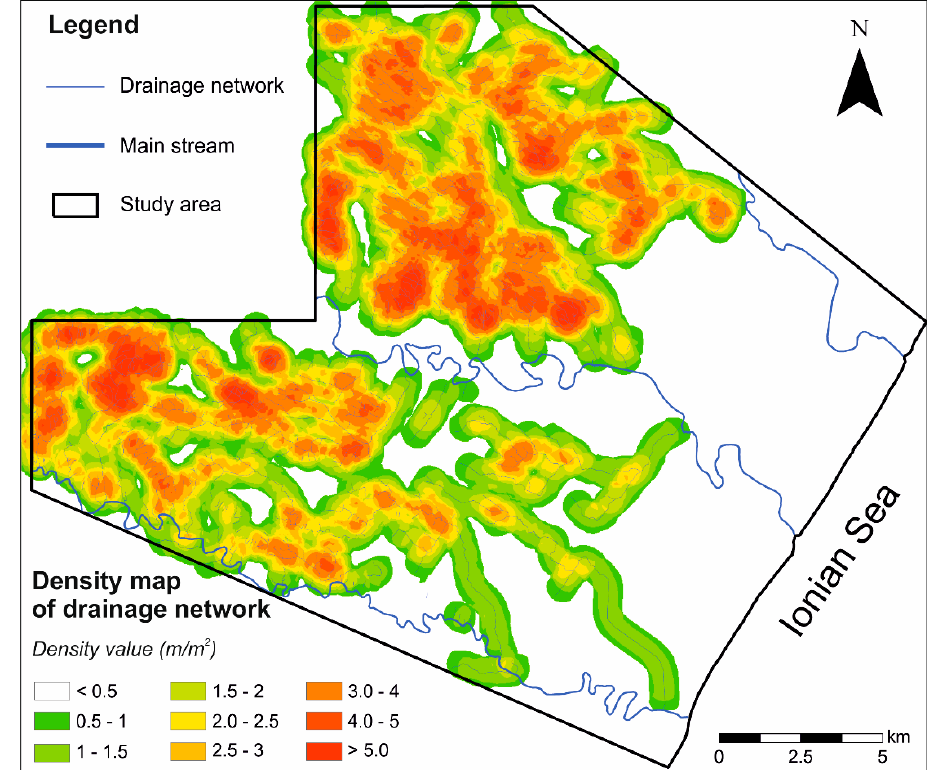
Figure 5. Drainage density map with a search radius of 500 m.